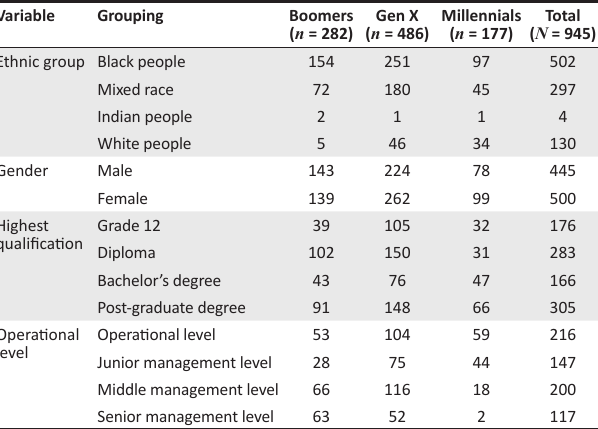
TABLE 1: Demographic profile of the